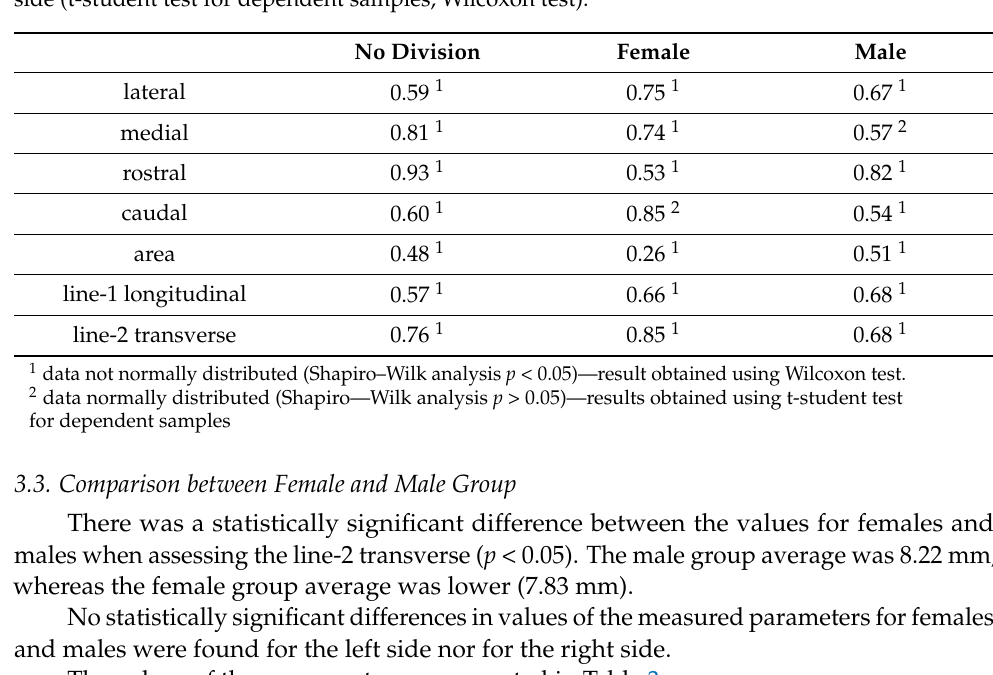
Table 2. The values of p parameter for comparison of measurements between the right and the left side (t-student test for dependent samples, Wilcoxon test).